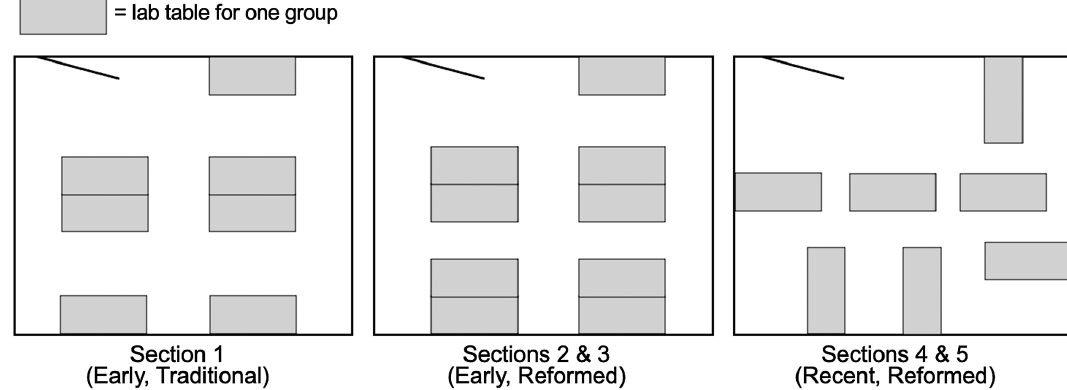
FIG. 1. Schematic of the classroom layouts for the five lab sections analyzed in this study. Solid black lines inside each layout represent the location of the classroom ’ s door. Classrooms for sections 1, 2, and 3 may have more than one lab group at adjacent tables. All lab tables (and lab groups) are physically separated in the classroom for sections 4 and